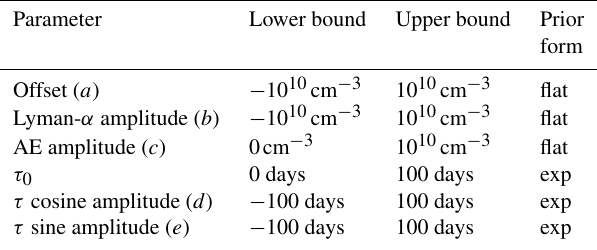
Table 1. Parameter search space for the non-linear model and un- certainty